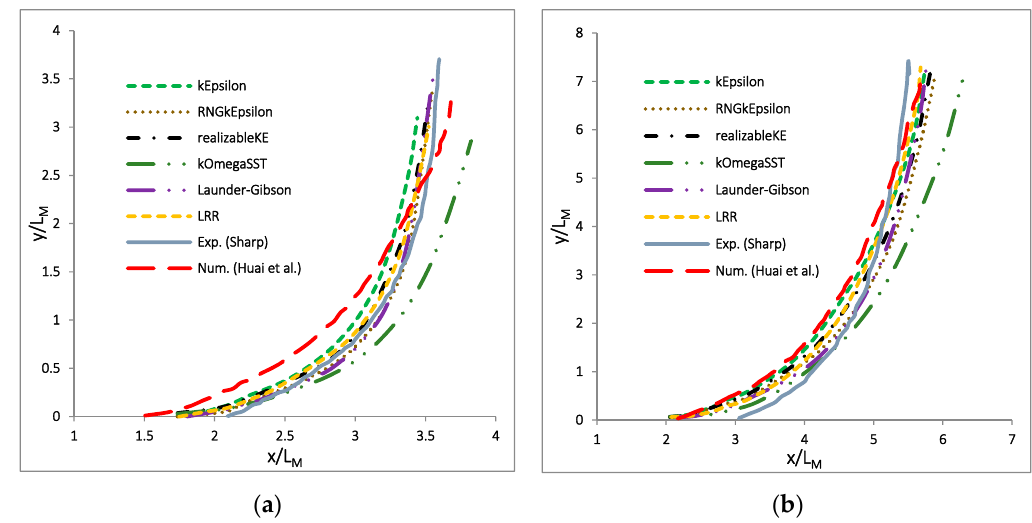
Figure 8. Centerline trajectory. ( a ) Fr d : approximately 12; ( b ) Fr d : approximately 20 (Source: [23]).